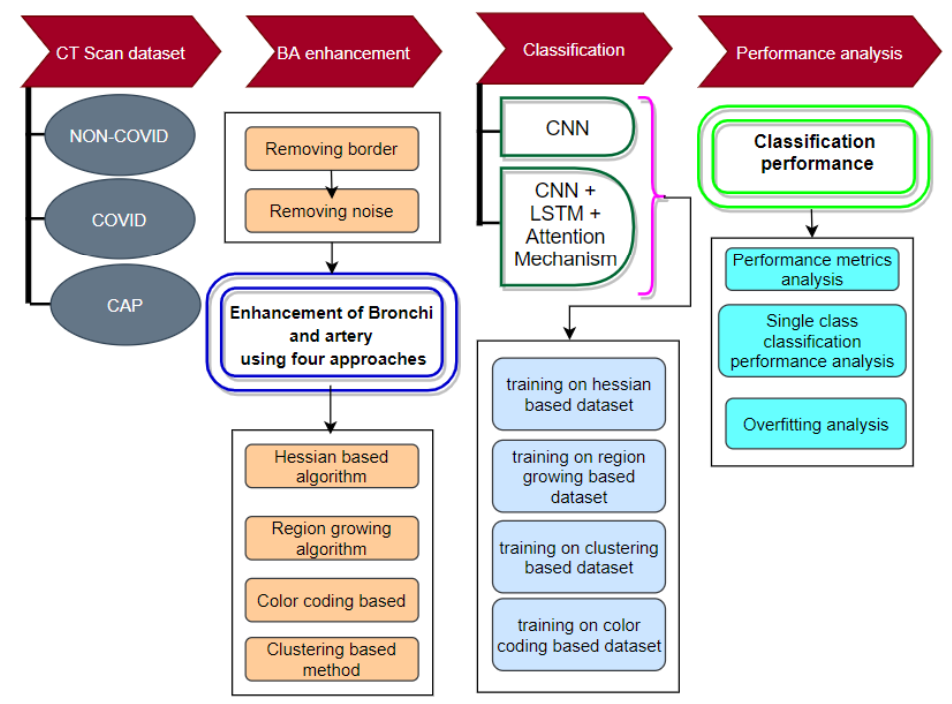
Figure 8. Flow diagram of the approach of this paper.